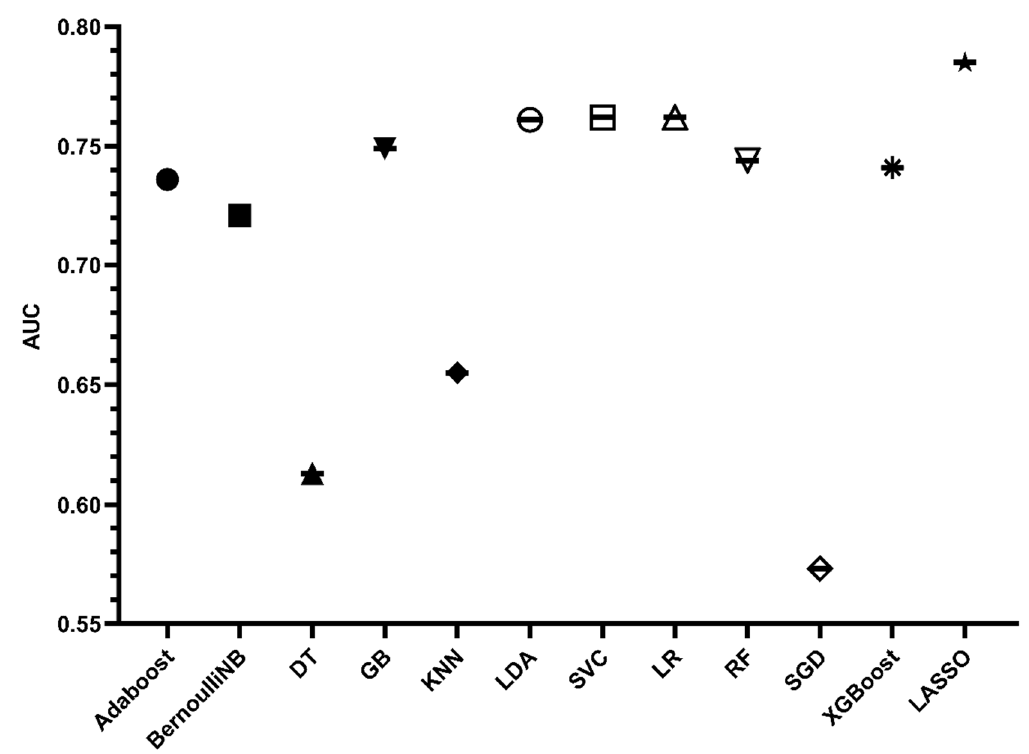
Figure 9. AUCs of nomogram and ML prediction models in training cohort.